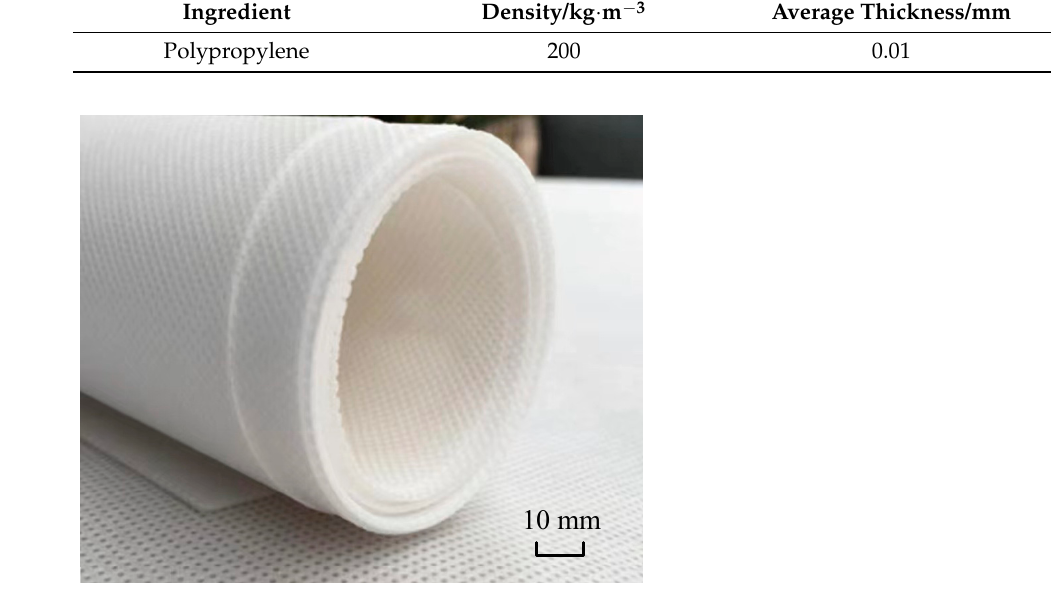
Figure 1. Photograph of non-woven fabric.